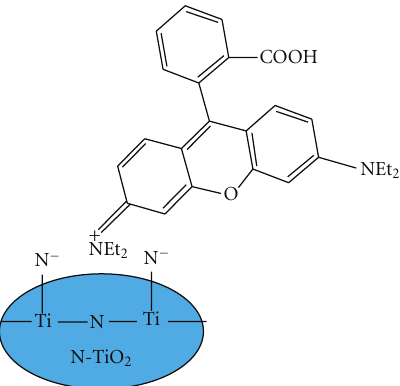
Scheme 1: Adsorption mode of RhB on the surface of N-doping TiO 2